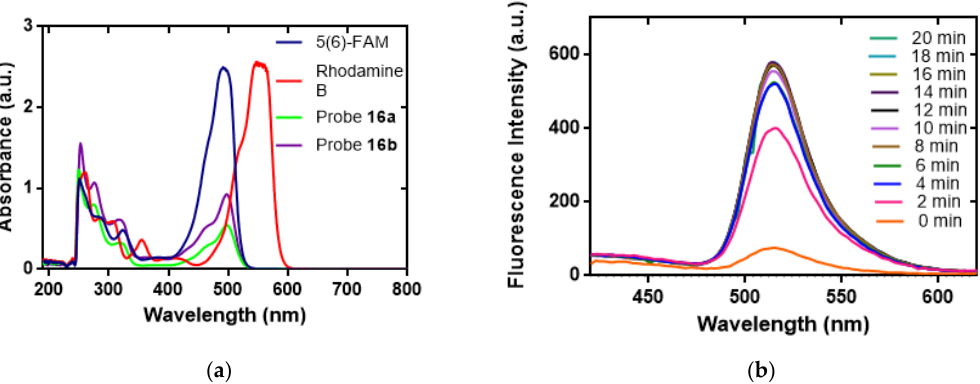
Figure 1. Contact quenching characteristics of the chemical probes 16 revealed by the UV-Vis absorption and the fluorogenic property of one of the chemical probes 16b when reacting with a thiol. ( a ) The UV-Vis spectra for 50 μ M of 5(6)-FAM (the blue curve), rhodamine B (the red curve), and the fluorescence chemical probes 16 (the light green curve for 16a ; the purple curve for 16b ) in phosphate buffer (PB; 10% dimethylformamide (DMF), pH 7.4). ( b ) The time-dependent increase in 6-FAM fluorescence in the reaction of 16b (1 μ M) with L-cysteine (50 mM) in PB.